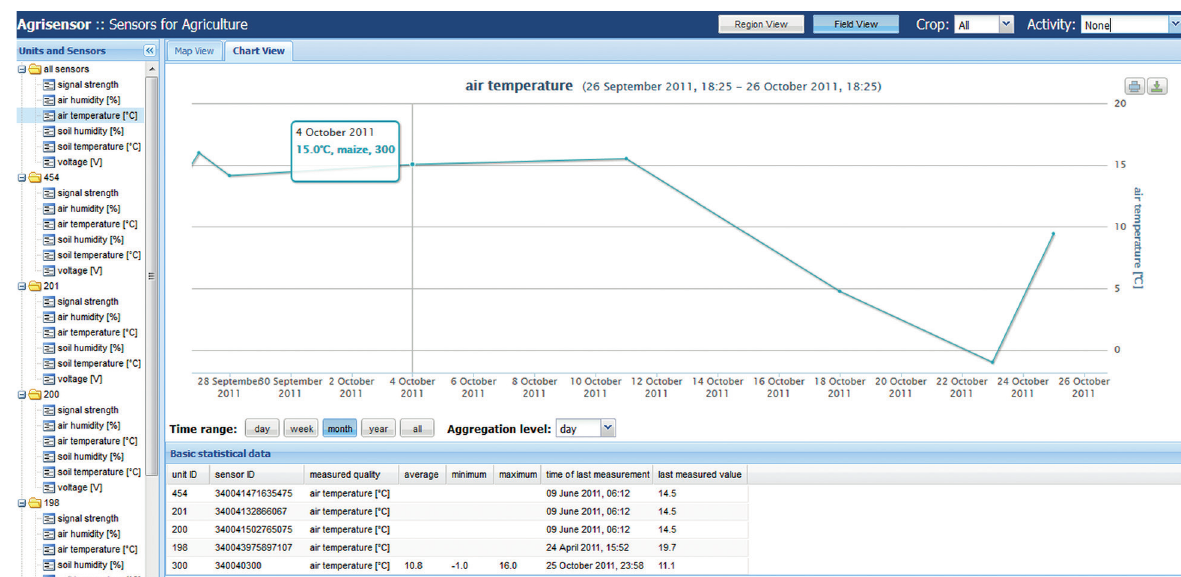
Fig. 2. Temporal visualization window presenting values from sensors that measure air temperature in time period 28th September – 26th October 2011. Aggregation level “month” is selected. Information about value in specific days (e.g. 4th October) is visualized after the movement of mouse over the